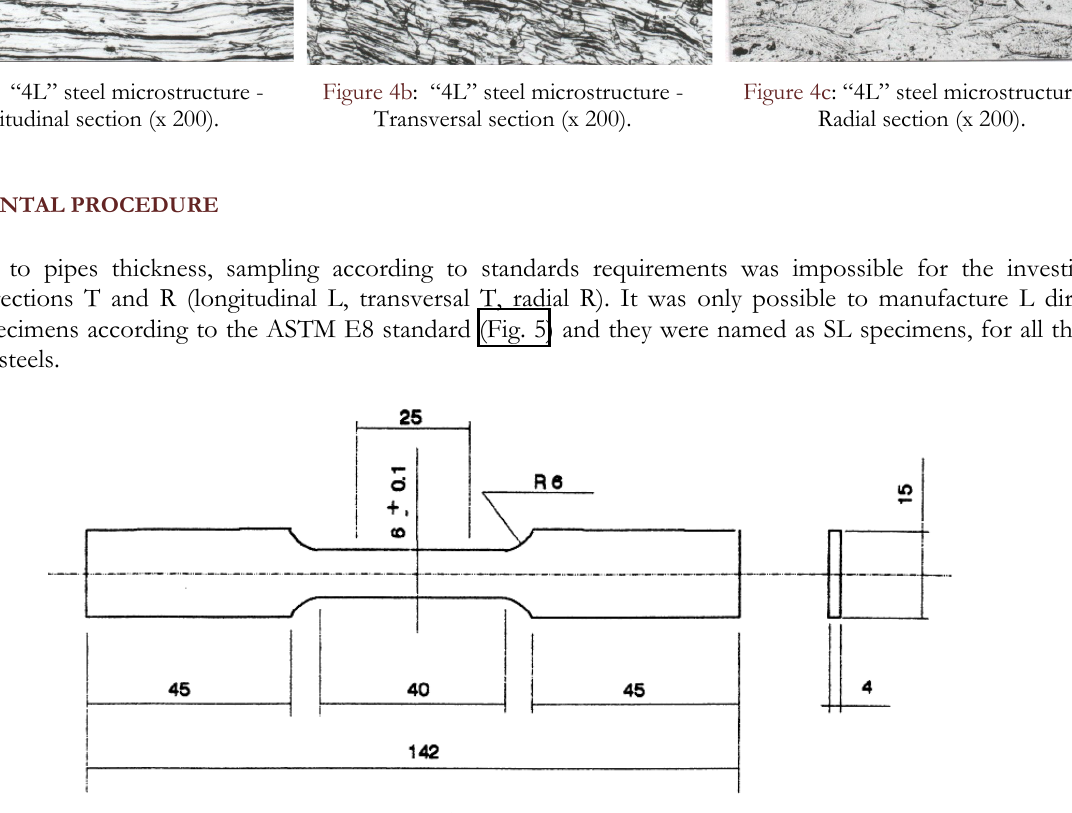
Figure 5: Standard specimen (S) for tensile